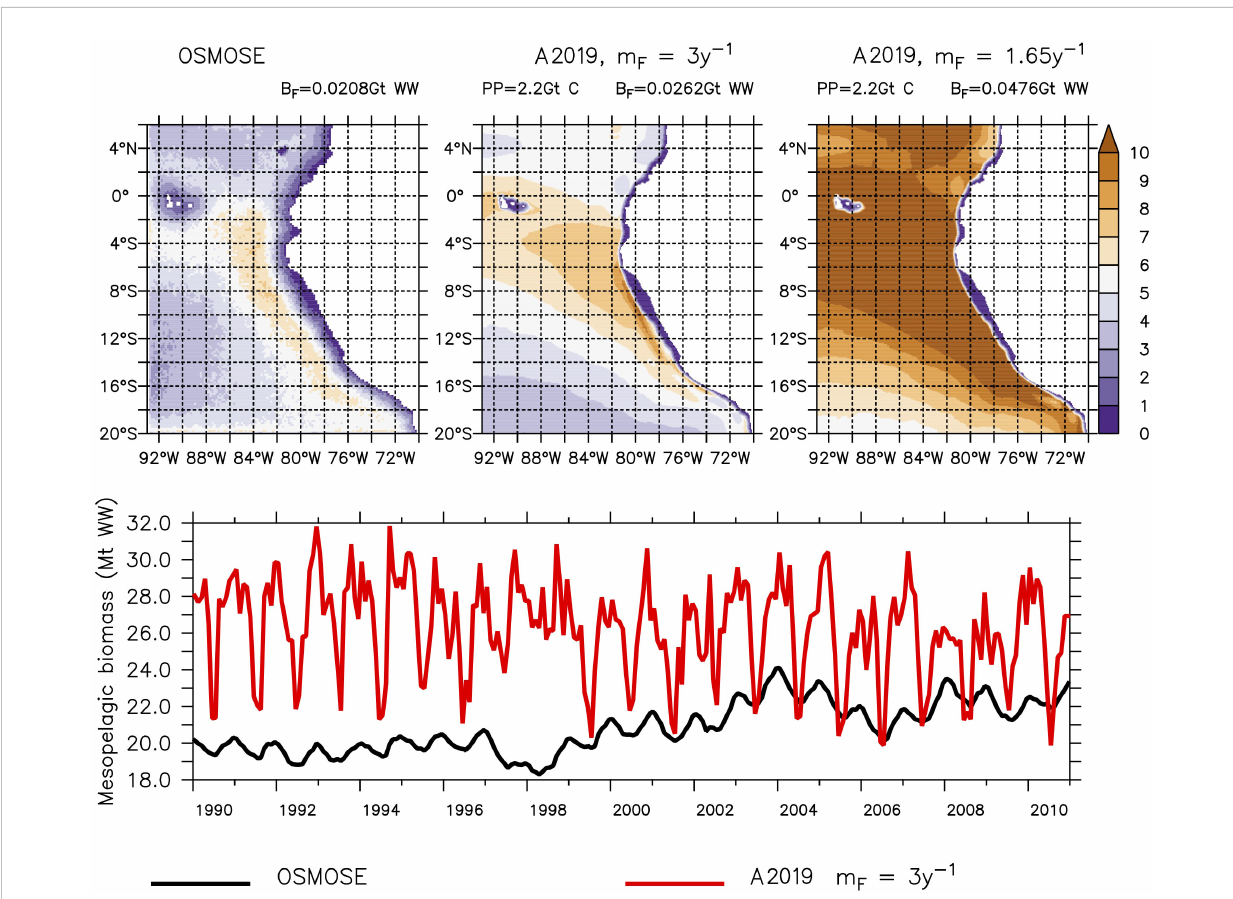
FIGURE 1 Mesopelagic fi sh simulated by OSMOSE (top-left and bottom-black) and the model by A2019 (top-middle, top-right and bottom-red), both models using input by CROCO – BioEBUS. The top row shows the averaged output in grams of wet weight per square meter (g WW m − 2 ) from 1990 to 2010 and the bottom shows the total biomass over the domain for the same time period. The top row also gives the spatially integrated total primary production (PP), the total mesopelagic fi sh biomass (B F ) and the mortality rate applied to the model by A2019 (m F ; see Table